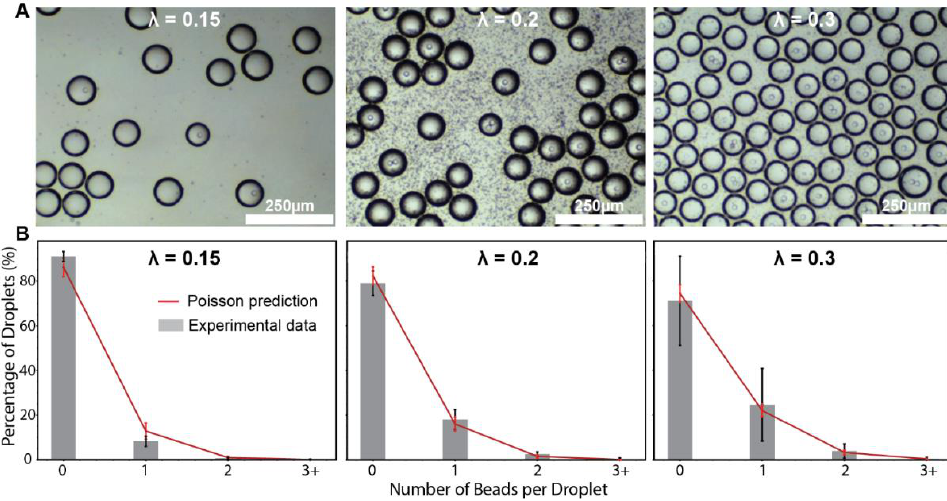
Figure 4. Dense bead in droplet (BiD) encapsulation at varying bead concentrations ( λ = 0.15, 0.2, 0.3). ( A ) Microscope images of BiD. ( B ) Poisson-predicted bead in droplets distribution in comparison to the observed experimental data.